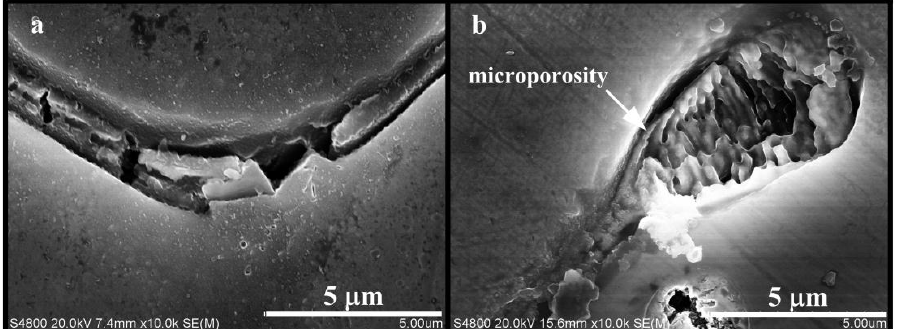
Figure 10. High-magnification SEM images of as-cast 7075 Al alloy without ( a ) and with 0.2 wt. % Sr ( b ).